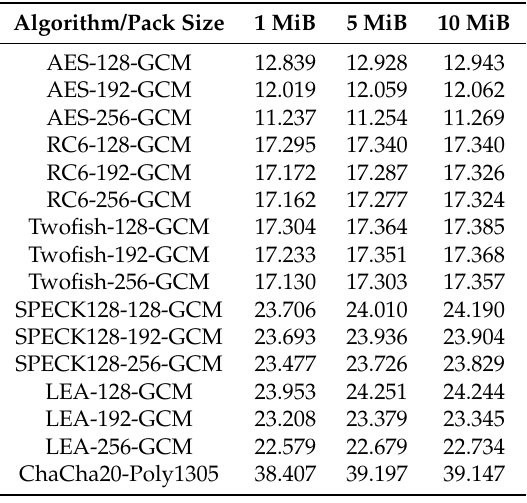
Figure A4. Average lightweight block cipher decryption time (seconds) in the ARMv7-a Samsung device. Table A1. Average decryption throughput (MiB/s) in the ARMv7-a Samsung